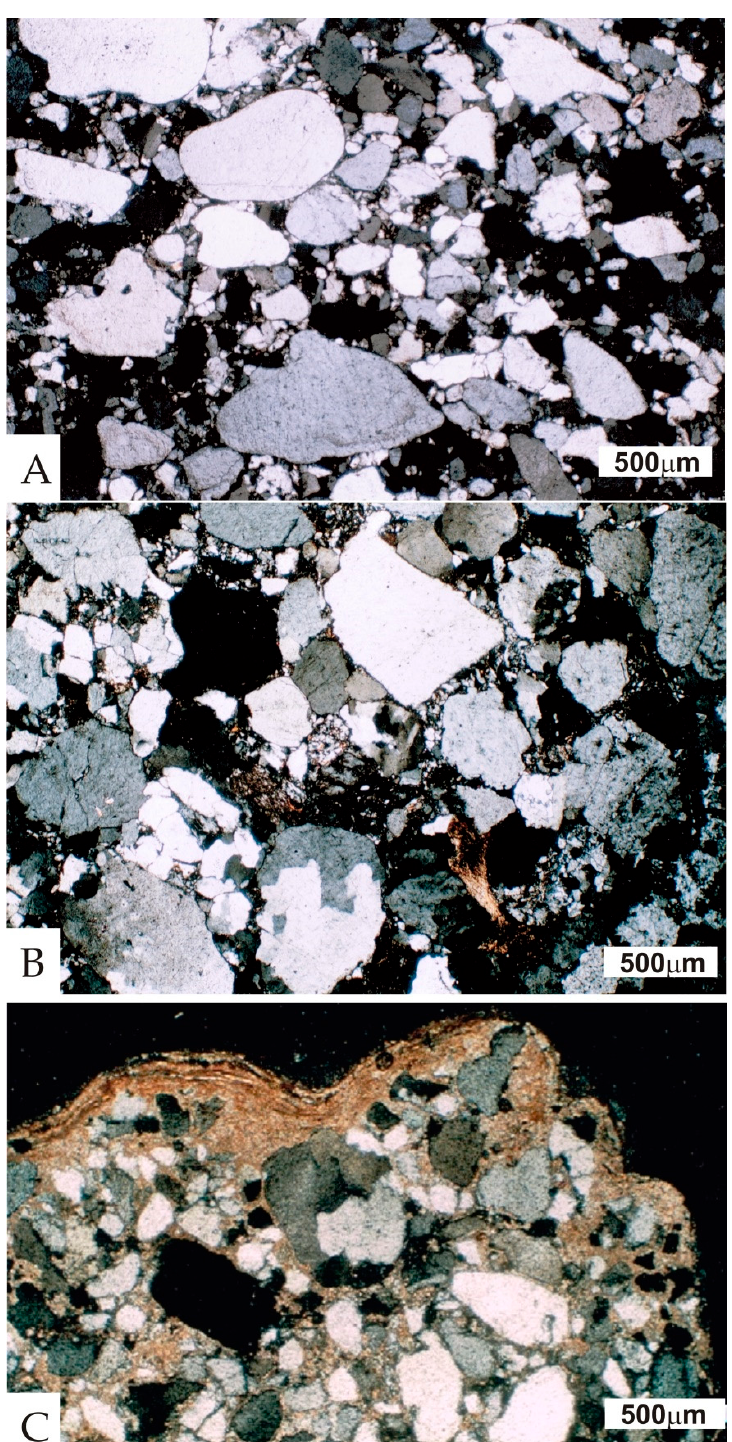
Figure 3. Thin section photomicrographs. ( A ) Poorly sorted sub-arkose showing clast-supported fabric and grains with high degree of roundness (Cueva del Arco). ( B ) Sub-arkose with feldspar and biotite grains showing fine-grained alteration and pore-filling kaolinite cement (Shelter 13, Peñas de Cabrera). ( C ) Stromatolite-like crust surrounding sandstone surface (Cueva del Tajo de las Figuras). Calcite cements filling intergranular pores and partially replacing both siliceous framework grains and cements. All photographs were taken under cross polarized light.